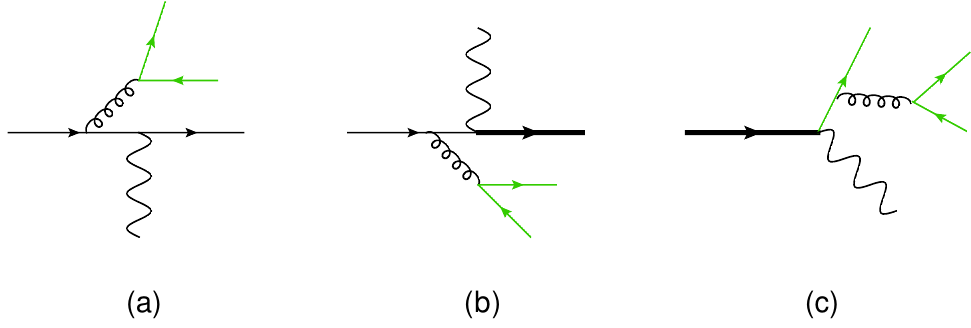
Figure 10 . Feynman diagrams with a soft gluon splitting into a b (cid:22) b pair, for NNLO corrections at the light-quark line, the heavy-quark line, and the top quark decay, respectively. The green fermion line represents a b quark or